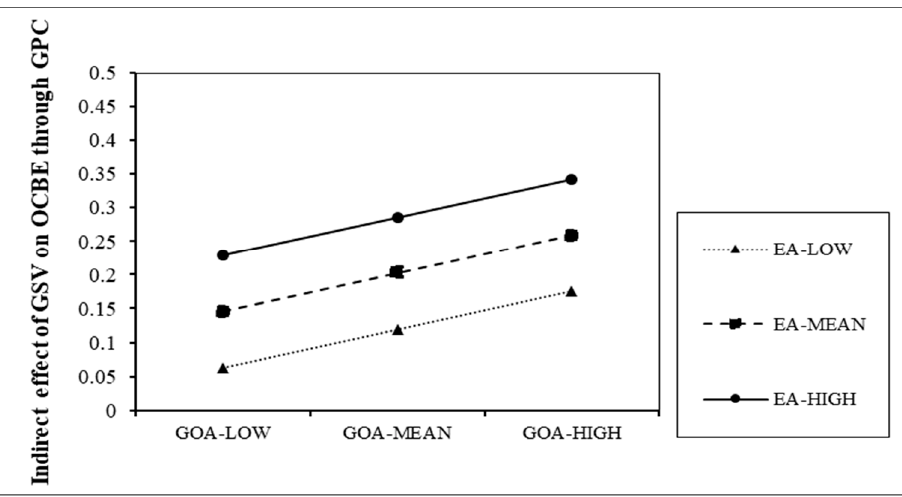
Figure 4. Indirect effect of green shared vision on OCBE via green psychological capital.